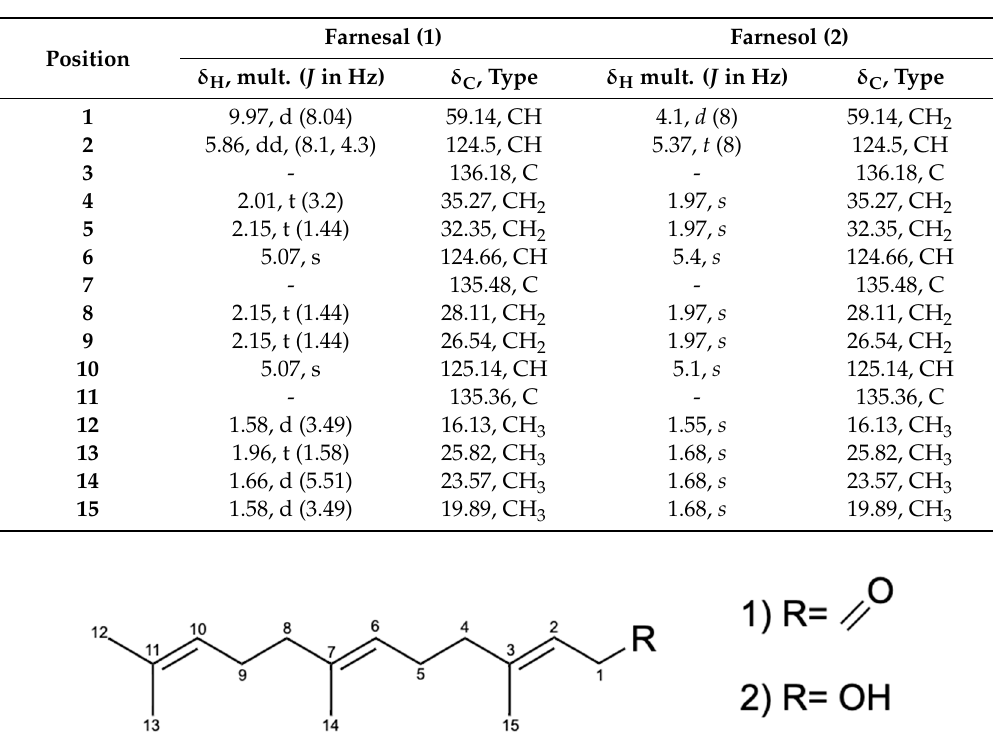
Table 4. 1 H and 13 C (700 MHz) NMR data of compounds 1 (farnesal) and 2 (farnesol) in CDCl 3 .